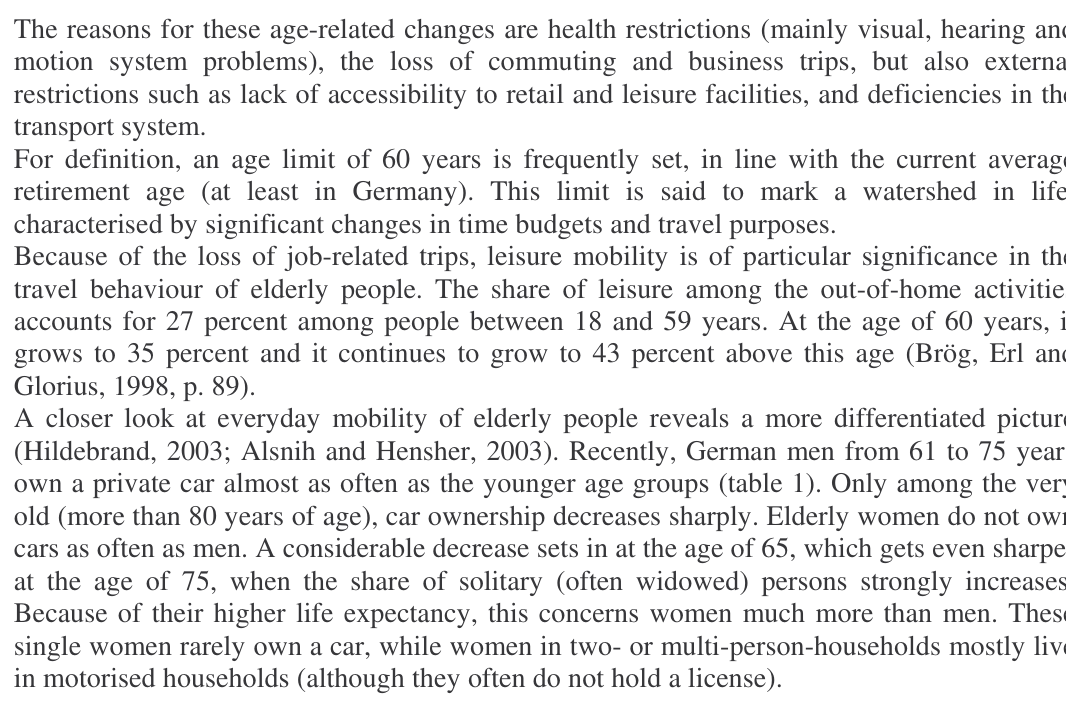
Table 1. Car availability by age group, household size and gender in Germany men women